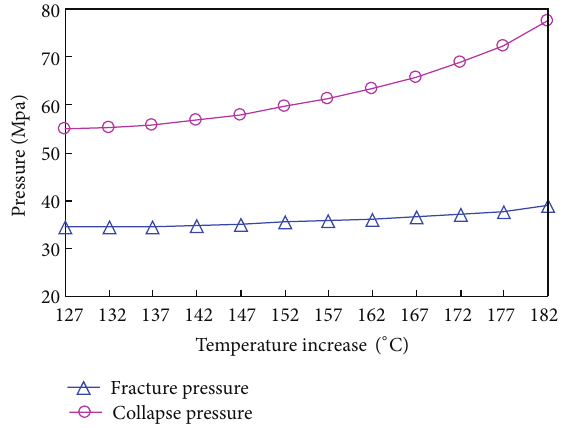
Figure 20: Variation of collapse pressure and fracture pressure with temperature increase.